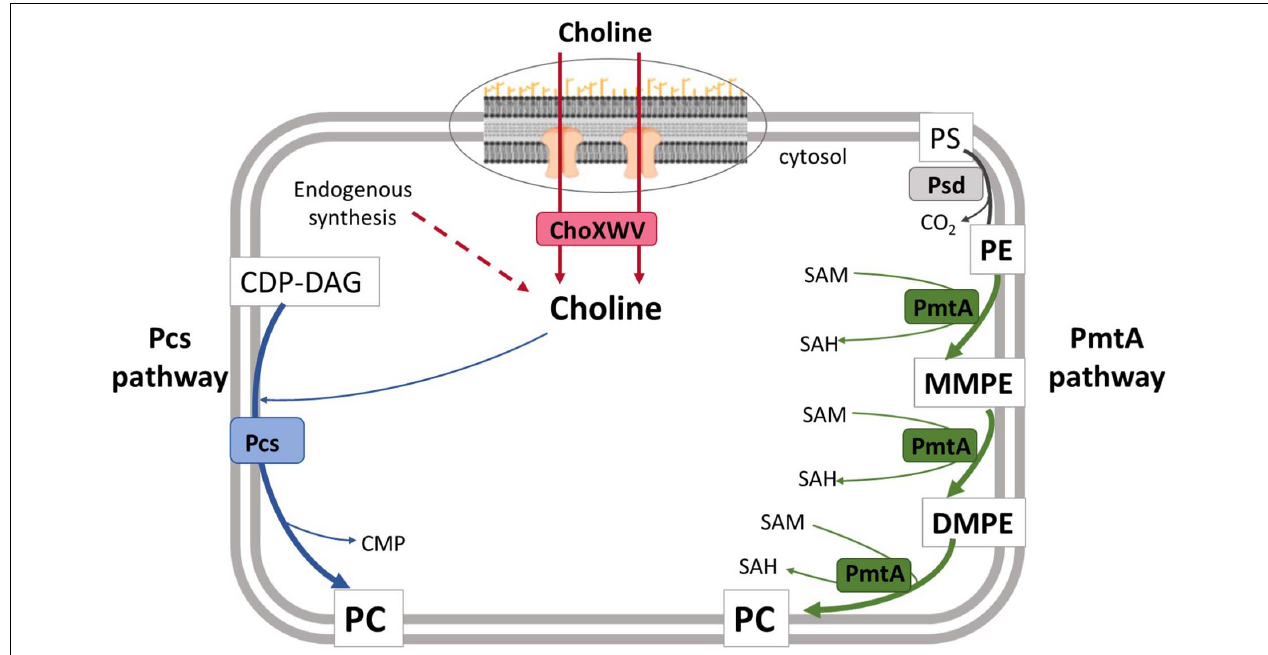
FIGURE 1 | Model for phosphatidylcholine biosynthesis in B. suis biovar 2. In the Pcs pathway, the membrane protein Pcs condenses CDP-DAG and choline to generate PC. This choline is taken up by the ChoXWV transporter. Dashed arrows indicate steps for which putative genes have not been identified in Brucella . In the PmtA pathway, three successive methylations catalyzed by PmtA convert PE to PC. PmtA, phospholipid N-methyltransferase; Pcs, phosphatidylcholine synthase; ChoXWV, high-affinity choline transport system; SAM, S- adenosylmethionine; SAH, S -adenosylhomocysteine, CMP; cytidine monophosphate; CDP-DAG, cytidine diphosphate diacylglycerol; PS, phosphatidylserine; PE, phosphatidylethanolamine; MMPE, monomethylphosphatidylethanolamine; DMPE, dimethylphosphatidylethanolamine; PC,